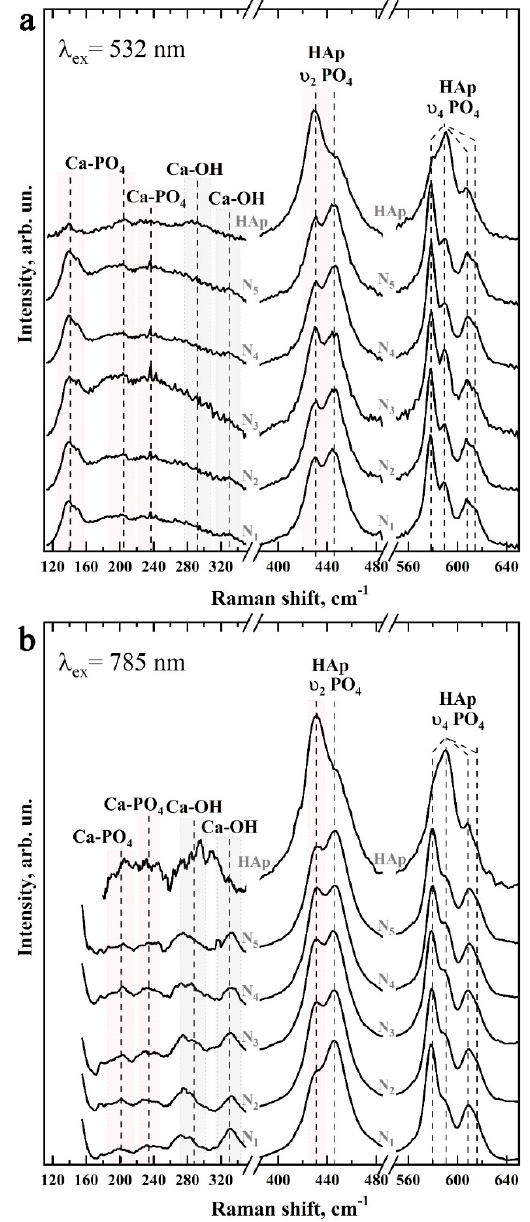
Figure 9. Raman spectra of samples N1–N5 and ncHAp in the regions 120–330 cm − 1 (left), 400–480 cm − 1 (center), and 560–640 cm − 1 (right): ( a ) excitation using 532 nm laser light; ( b ) excitation using 785 nm laser light.